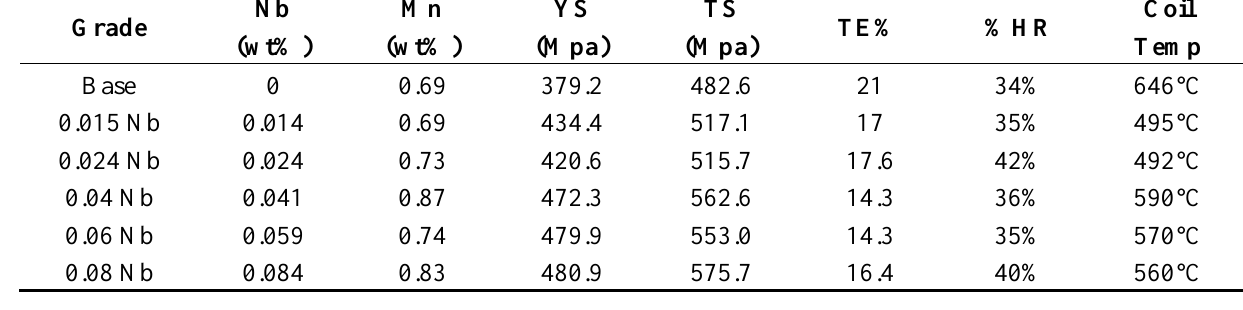
Table 4. Average mechanical properties from production coils produced from the CASTRIP process, with the percentage hot rolling (%HR) and average coiling temperature.